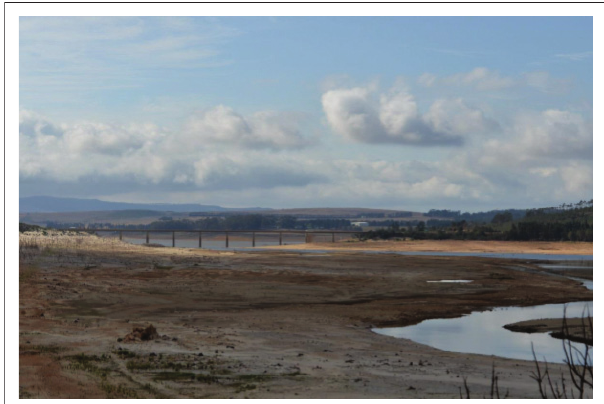
FIGURE 1: Theewaterskloof dam levels in January